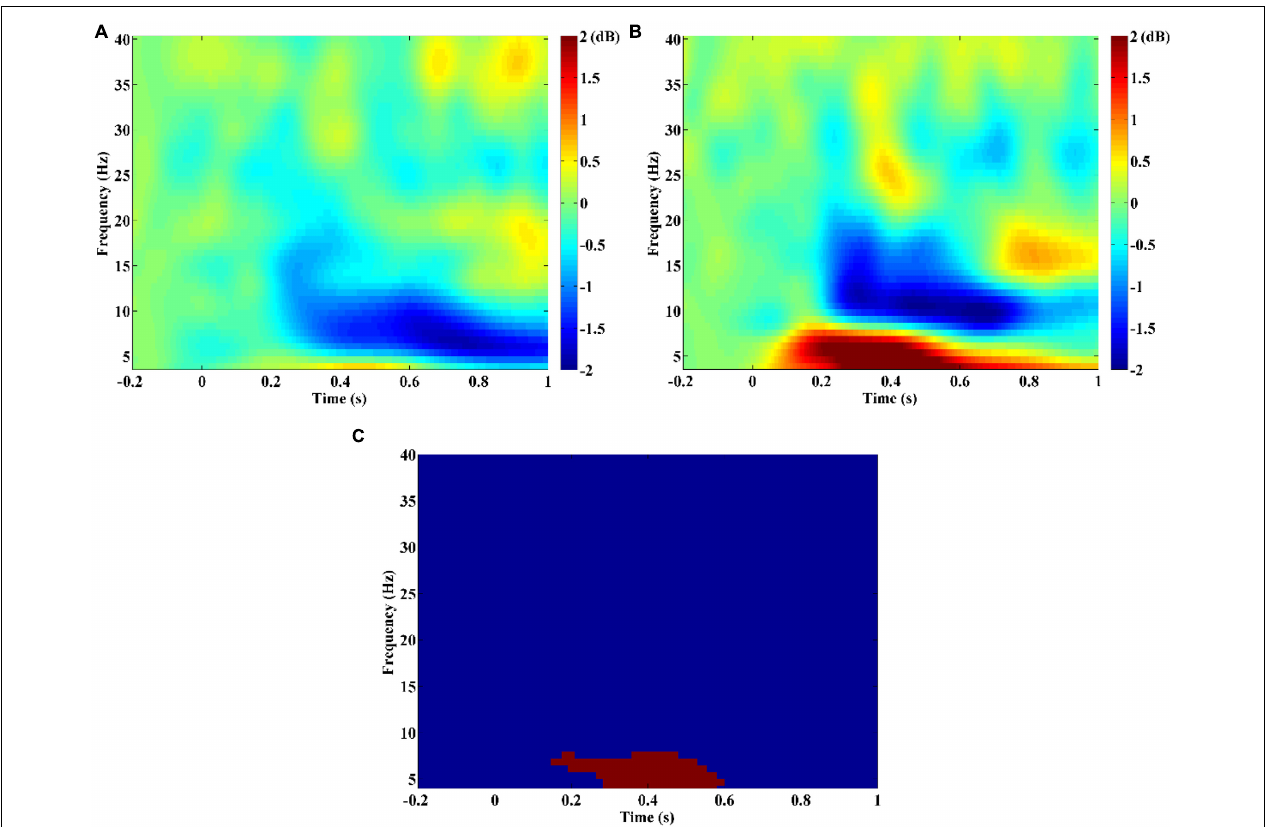
FIGURE 1 | Time-frequency power maps for (A) schizophrenia (SZ) and (B) healthy controls (HCs). Time-frequency power maps were averaged over two channels (F3, F4) and plotted as 10log10 change over baseline (from − 0.2 to − 0.1 s). (C) The result of the statistical comparison. Red color indicates time–frequency regions with significant difference between two groups, and blue color indicates no significant